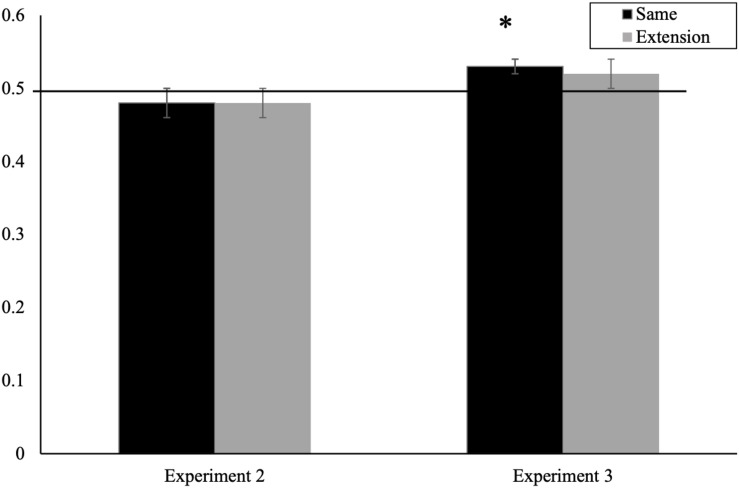
Mean proportion looking time during same and extension trials for Experiment 2 and Experiment 3 (∗significantly greater than chance, p < 0.05). Error bars represent standard error.